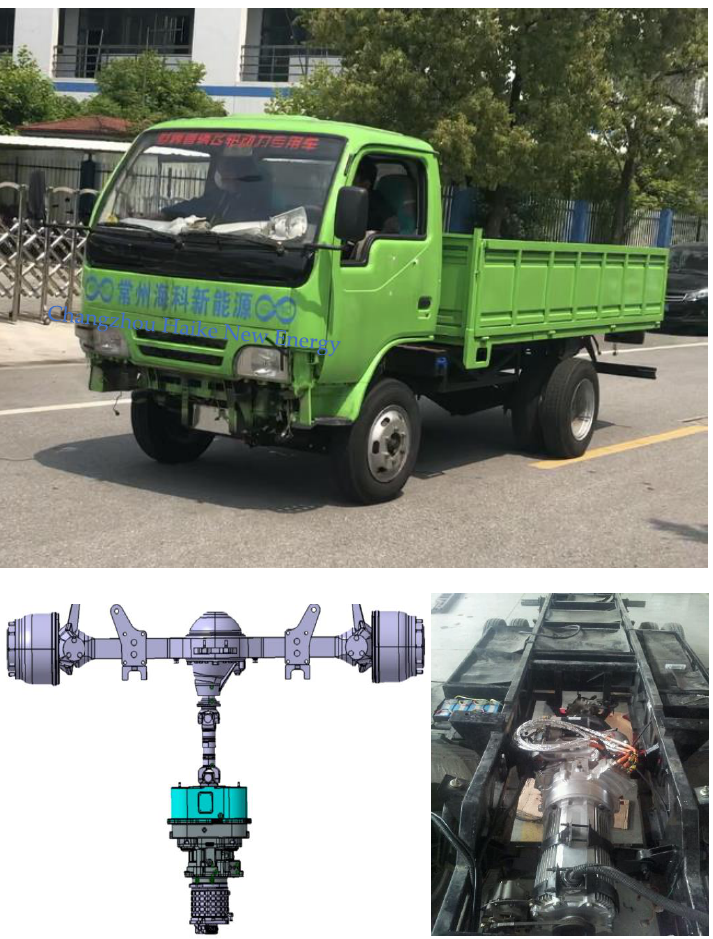
Figure 9. Tested range-extended electric light truck with i-KERD assembly shown in the chassis.